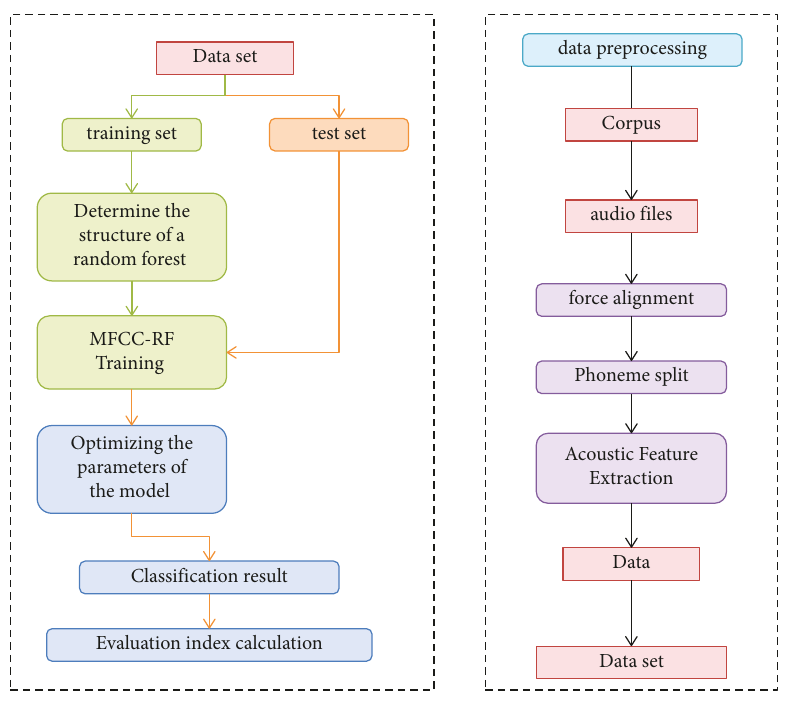
Figure 5: Pronunciation error detection process based on this